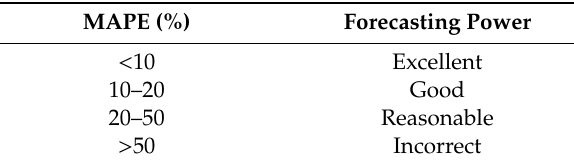
Table 15. Criteria of mean absolute per error (MAPE).